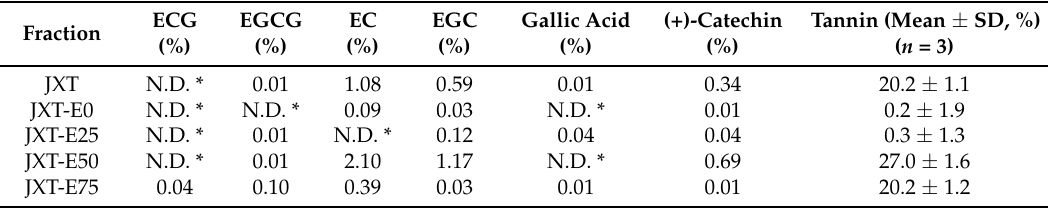
Figure 8. Anti-HCV replication effects under the combined treatment with EGCG and ECG in HCV replicon cells. Huh-luc/neo-ET replicon cells were incubated with different concentrations of EGCG and ECG for 72 h alone or in combination. The ratios of the detected EC 50 of EGCG and ECG alone or in combination at EC 50 of single compound were plotted against each other in an isobologram. Each point on the isobologram represents a combined treatment that inhibited 50% of HCV replication (mean ± SD from three separate experiments). Table 3. Content of polyphenols and tannins in the crude water extract of S. suberectus and ethanol fractions from macroporous resin.